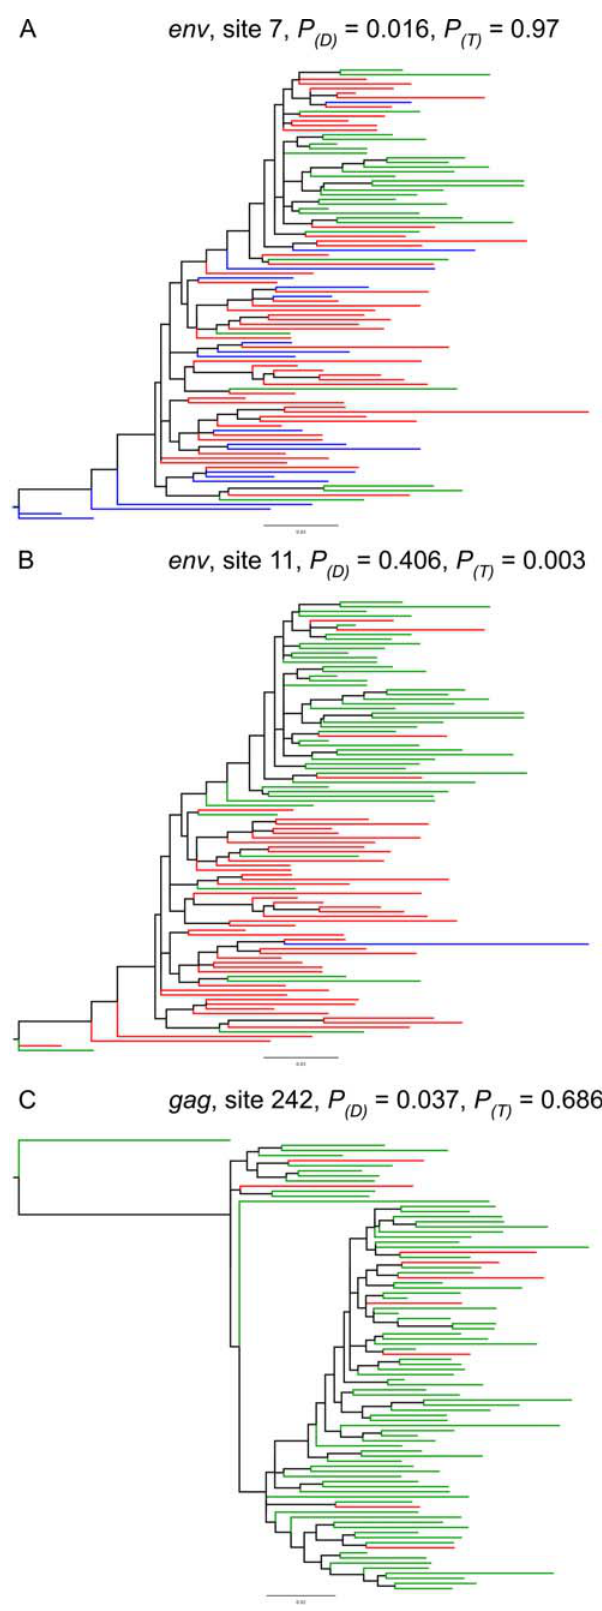
Figure 4. Evidence of toggling and diversifying selection in real data. Tree branches are coloured according to the codon category of the nodeatthe rightend ofthe branchforsites detectedtobe(A)